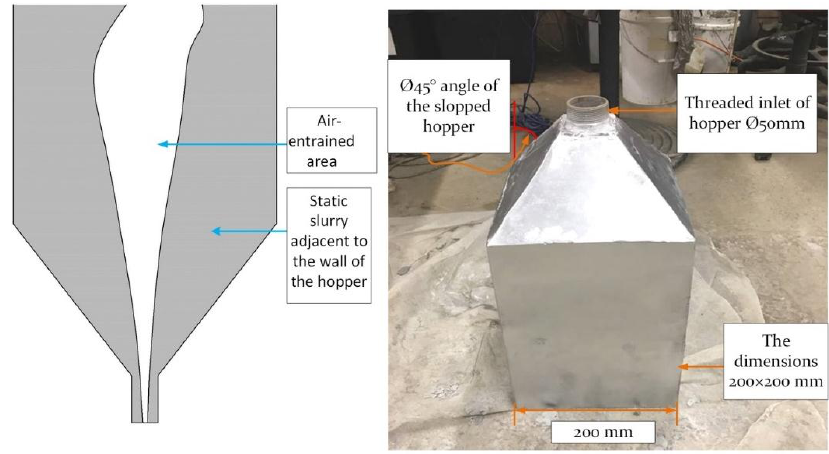
Figure 12. The hopper with an angle of Ø 45° and the core-flow concept.